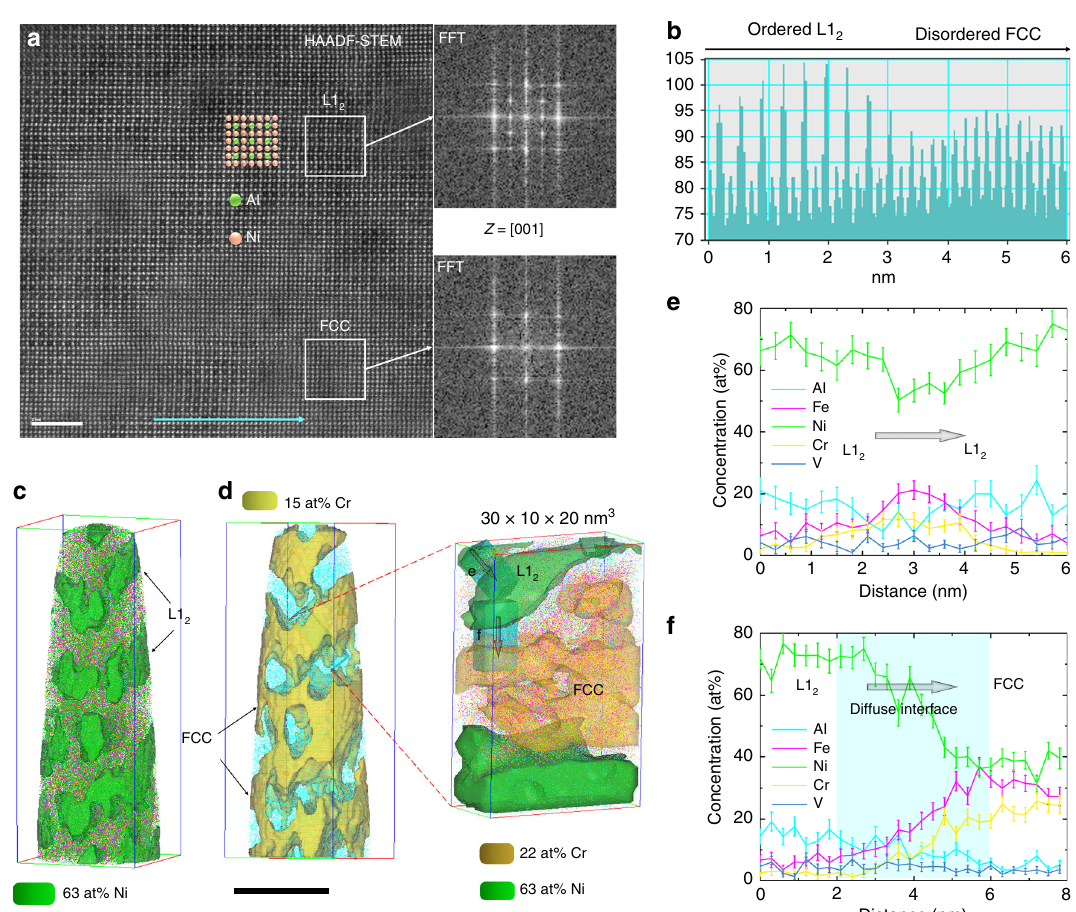
Fig. 3 Composition, morphology and structure of phases existing in the bright matrix region of 600 A. a Atomic mass contrast in atomic-resolution HAADF-STEM images revealing a distinctive nanostructure consisting of a disordered FCC matrix and ordered L1 2 phases with diffuse coherent interfaces. Scale bar, 2 nm. b Intensity pro fi le along the cyan arrow marked in a showing atomic arrangement in the two phases. c , d Three-dimensional reconstruction of 63 at% Ni and 15 at% Cr isoconcentration surfaces presenting the morphologies of the ordered L1 2 precipitates and disordered FCC matrix, respectively. A box was selected from d to provide more details about the morphology and composition of the two phases. Scale bar, 40 nm. e , f One-dimensional concentration pro fi les showing the element distributions from L1 2 to L1 2 and L1 2 to FCC, respectively. Error bars,